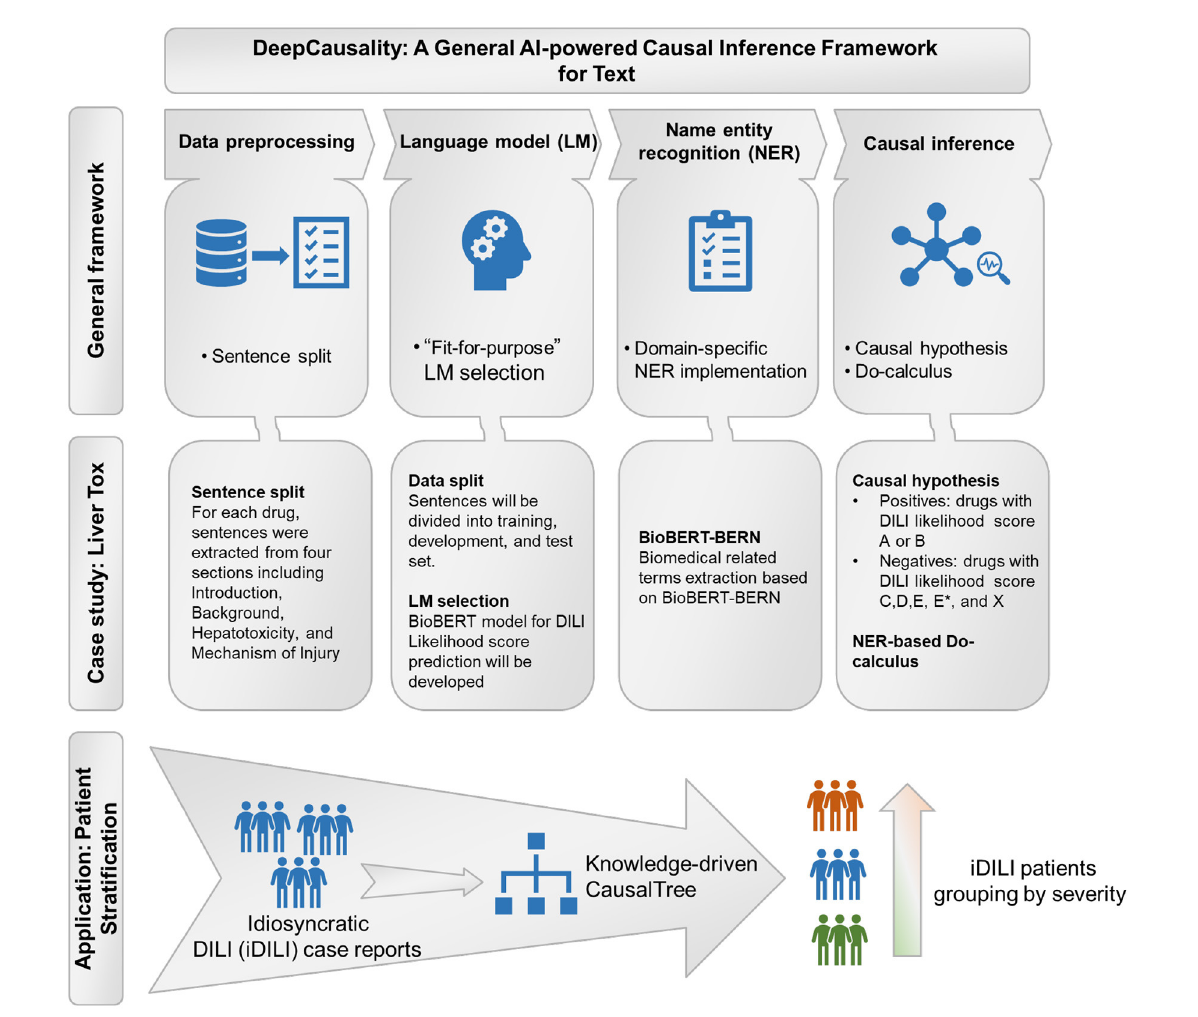
FIGURE1 The workflow of the study: General framework of the DeepCausality, case study with LiverTox, and idiosyncratic DILI (iDILI) patient stratification.